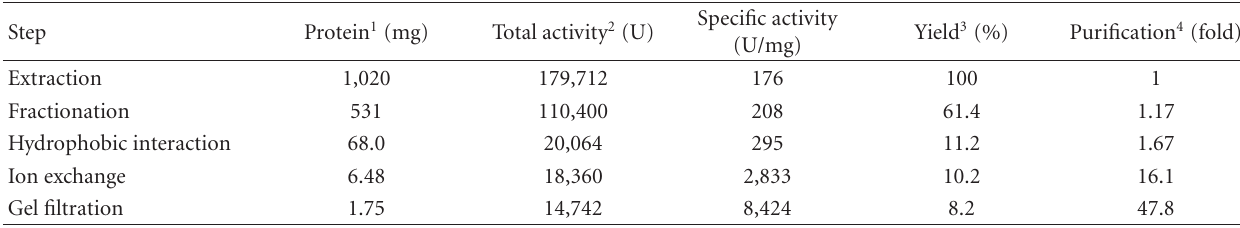
Table 1: Typical steps of the CeSP